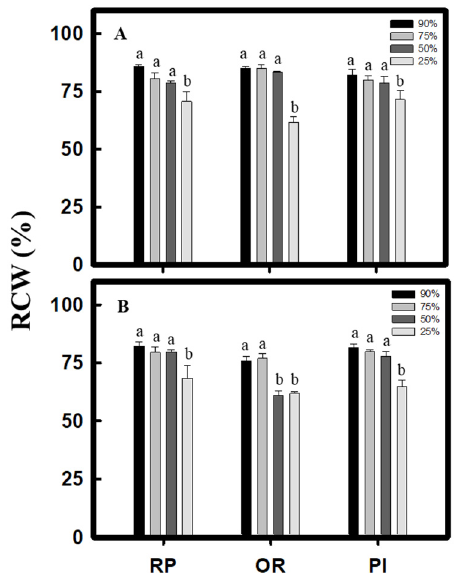
Figure 2. Effect of drought stress on relative water content (RWC) in C. formosana and C. quinoa . C. formosana RP variety, OR variety, and C. quinoa PI variety grow to vegetative stage (5 weeks after transplanting) ( A ) and reproductive stage (8 weeks after transplanting) ( B ); the water content was investigated, respectively. Bars show means ± SE. Values with the same letter are not significantly different in treatments between the same variety by LSD ( p < 0.05, n = 4).